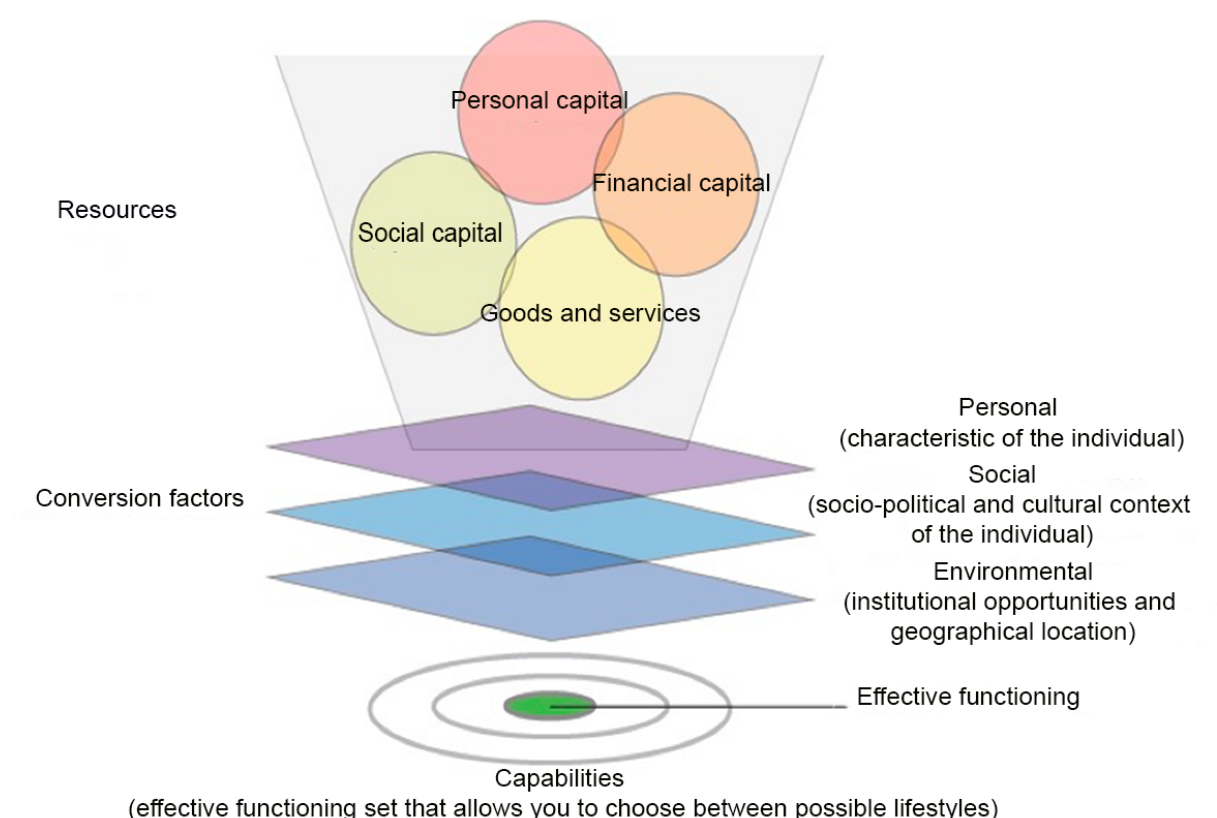
Figure 1. Representation of the Capability